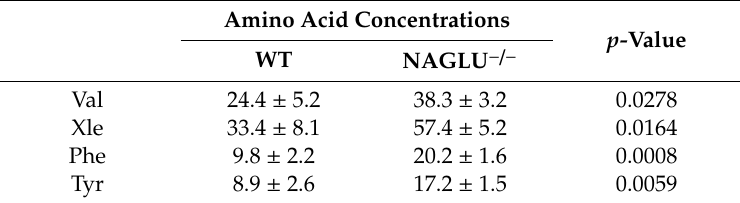
Figure 4. Branched-chain and aromatic amino acid accumulation in the heart of NAGLU − / − mice. Results are represented as the mean ± standard error of the mean (SEM). The statistical significance of the di ff erence in metabolite tissue concentrations between genotype conditions (NAGLU − / − and WT) was evaluated by parametric or non-parametric tests when data failed the Shapiro–Wilk normality test. * p < 0.05, ** p < 0.01, *** p < 0.001. Table 1. Di ff erentially abundant metabolites in the